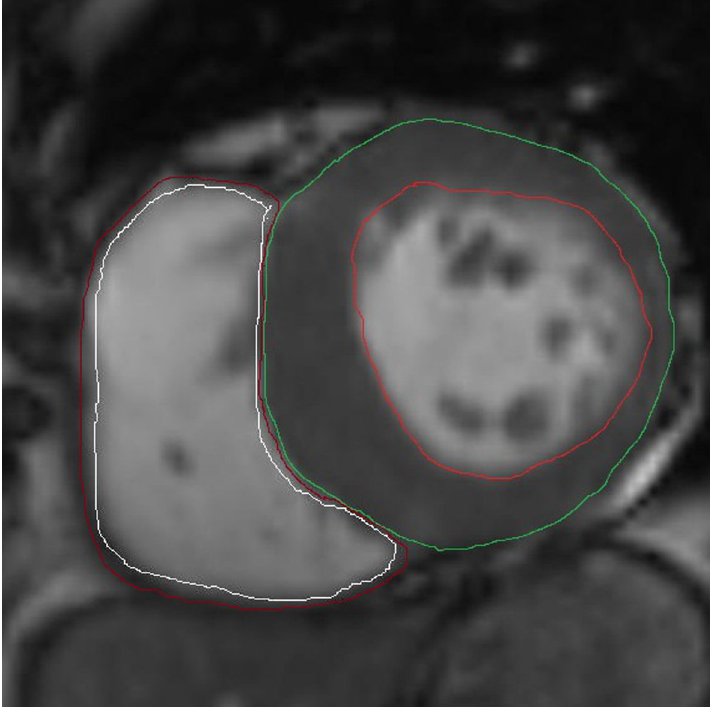
Figure 1. Cardiac images show an example of left and right ventricular function data obtained from the patient at end-diastole phase using MRI.